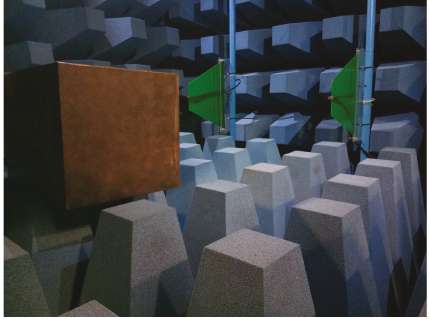
Figure 6: Experimental setup of target identi fi cation systems.